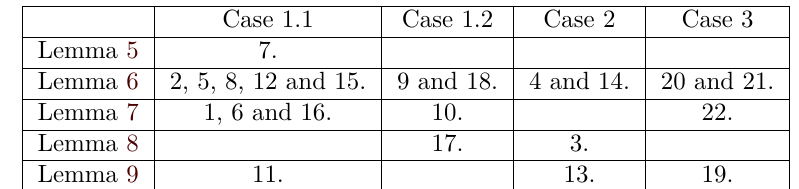
Table 4: Classification of GCTR variants according to their corresponding case and applicable